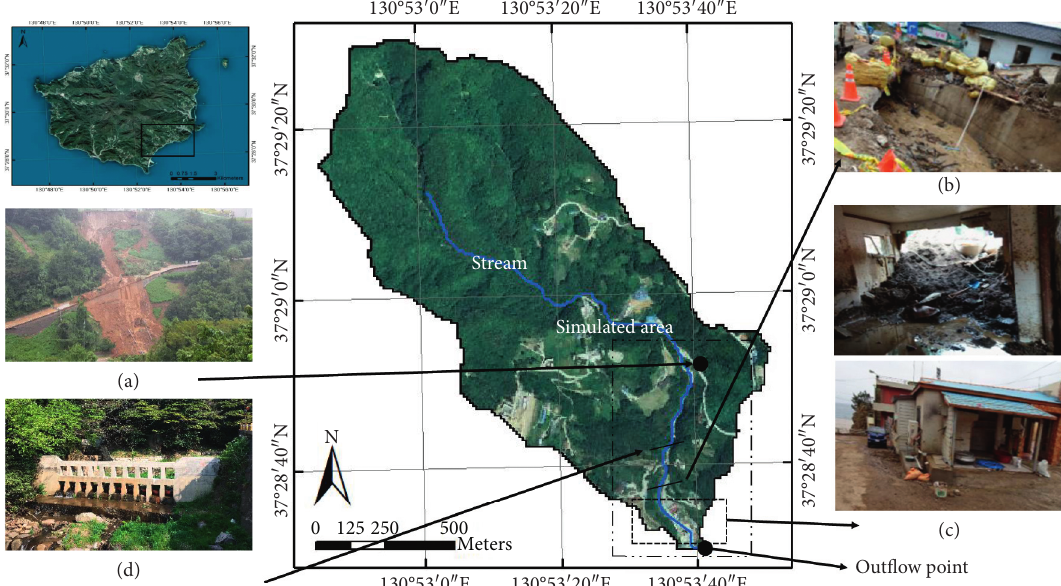
Figure 4: Debris flow occurrence in the study area and the damage inflicted. (a) Trigger point. (b) Covered open channel. (c) Damaged area. (d) Open-type check dam (installed after debris flow).